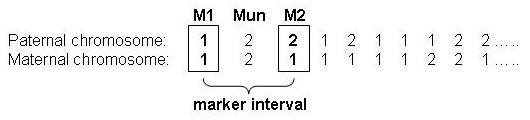
Definition of marker interval, ungenotyped marker (Mun), and adjacent markers (M1, M2, ...) used for the genetic diversity estimation. The ungenotyped marker is placed in the middle of the marker interval; genetic diversity was estimated for each marker interval, using the adjacent markers left and right of the interval.